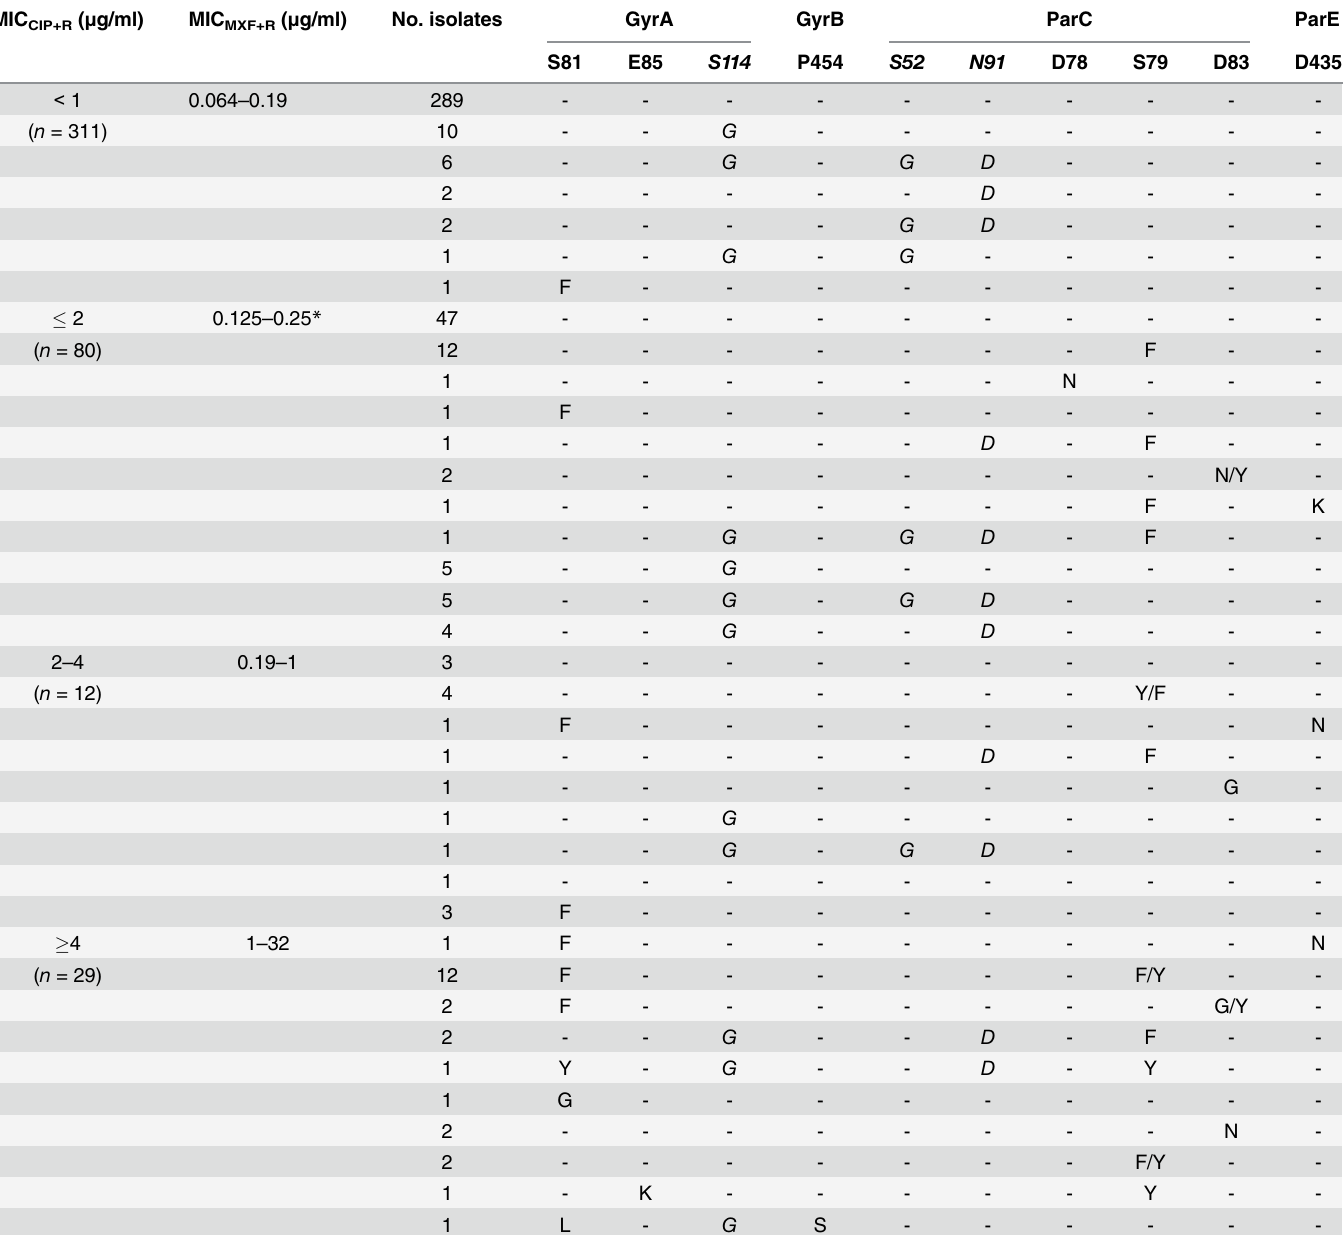
Table 2. Overview of the various FQ-R genotypes encountered in 422 clinical S . pneumococci strains. Signature residues of the viridans group of streptococci [13] are indicated in bold. MIC CIP+R ( μ g/ml) MIC MXF+R ( μ g/ml)